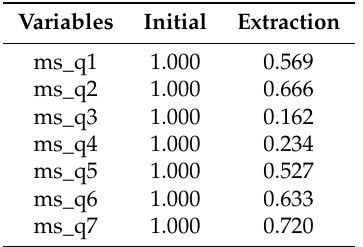
Table 5. Communalities of the Manufacturing